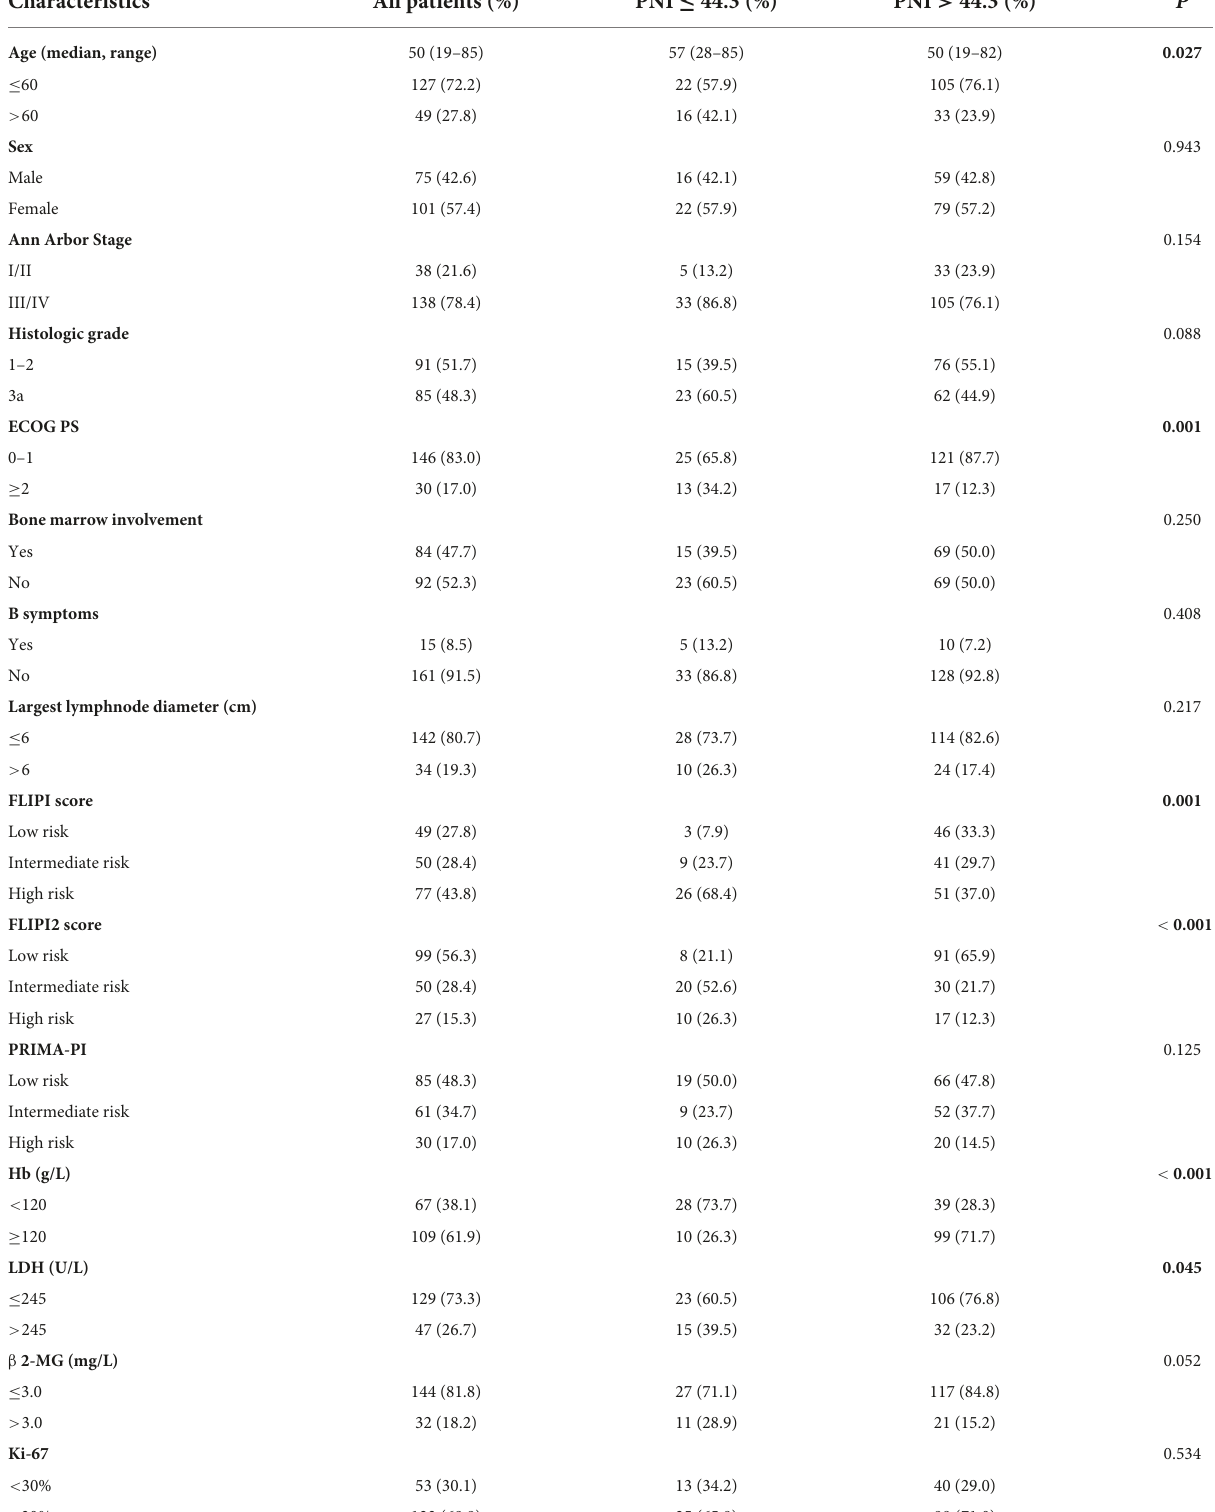
TABLE 1 Comparison of patient characteristics between PNI